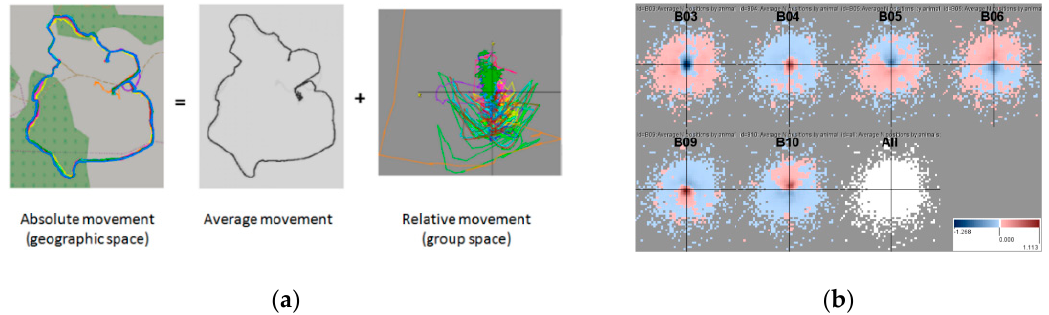
Figure 23. ( a ) Fundamental idea; and ( b ) a baboon visualization example of spatial transformation [65].